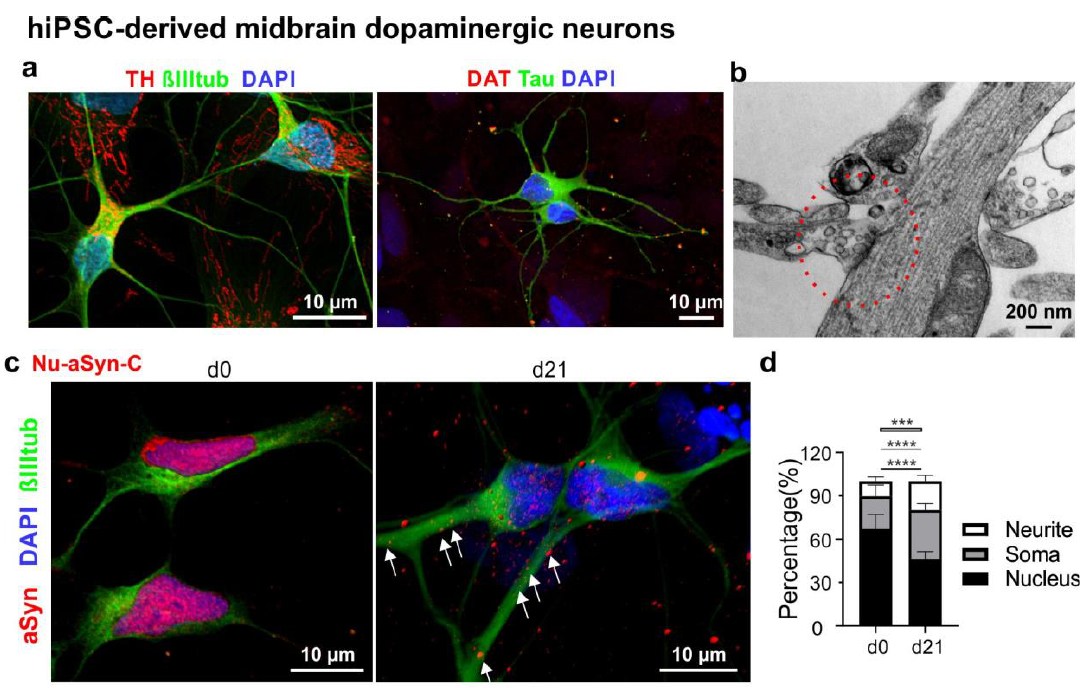
Figure 5. Characterization of mDANs differentiated from hiPSCs. ( a ) Representative neurons differentiated for 21 days show the presence of the neuronal markers β IIItub and Tau (green) as well as the dopaminergic neuronal markers TH and DAT (red). ( b ) Representative EM image of a putative synaptic site (red circle) with synaptic vesicles in hiPSC-derived neurons differentiated for 21 days. ( c ) Representative immunofluorescence images of proliferating smNPCs (d0) and neurons differentiated for 21 days (d21) labelled with the Nu-aSyn-C antibody, an anti- βIIItub antibody, and DAPI. Immunosignals for aSyn and DAPI were reconstructed in 3D to demonstrate the distribution pattern of aSyn. ( d ) Quantification of aSyn distribution (in %) in the nucleus, soma and neurites. The Nu-aSyn-C antibody detects aSyn in the nucleus of proliferating cells (d0). Upon differentiation (d21), aSyn signal intensity significantly decreases in the nucleus and increases in the soma and neurites. For quantification, data represent the mean ± SD of >16 cells of each time point measured in three independent experiments. Two hiPSC lines (UKERi33Q-R1-006 and UKERi1E4-R1-003) from two healthy individuals were used. Statistics: Two-way ANOVA, Tukey’s multiple comparisons test, *** p < 0.0005, and **** p < 0.0001. Black lines: comparisons of nuclear signal intensity; grey lines: comparisons of soma signal intensity; white lines: comparisons of neuritic intensity.